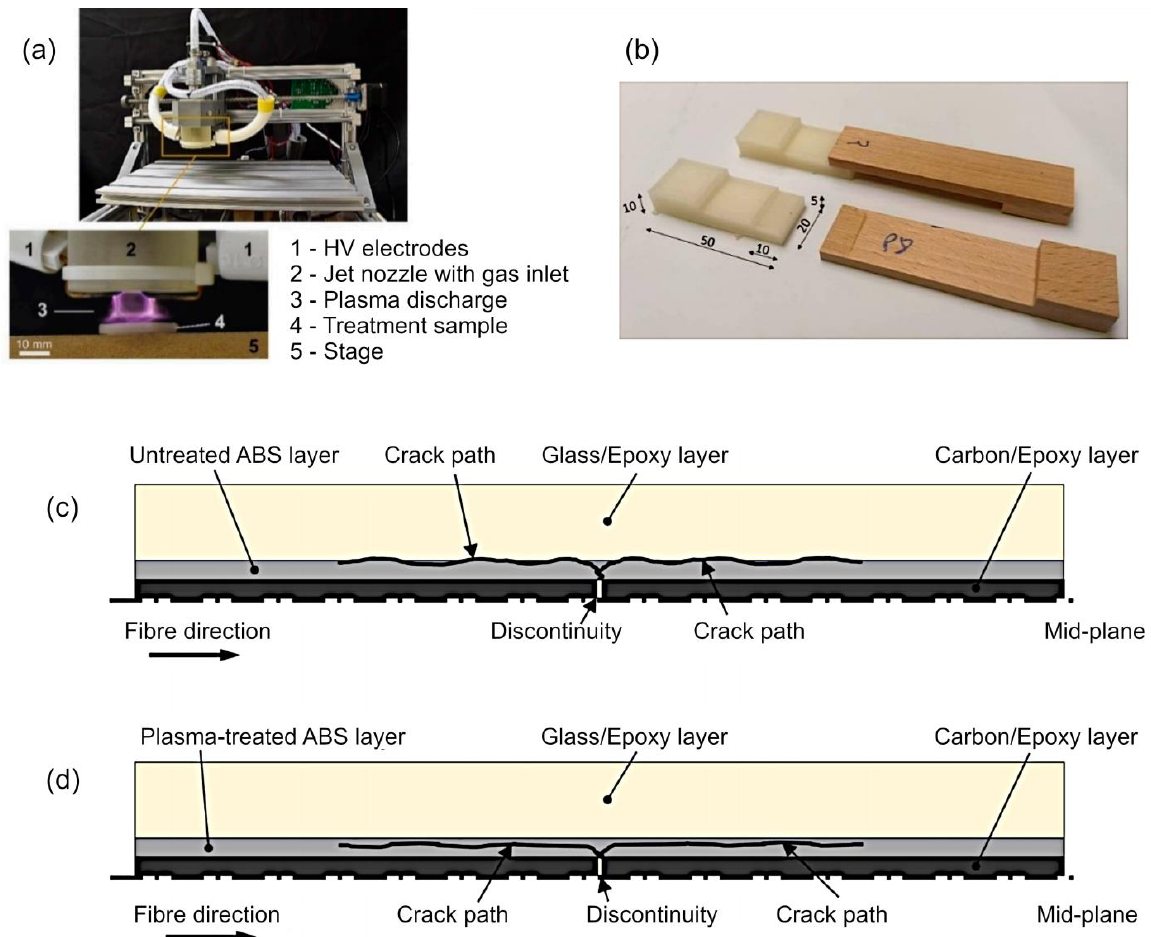
Figure 10. ( a , b ) Plasma device used for the surface treatment of 3D-printed samples on a CNC positioning system (top left image) with a gliding arc plasma jet ( a ), and sample for testing the bond shear strength ( b ). Reproduced from Kariž et al. (2018) [91] under conditions of the CC BY license. ( c , d ) Representation of the crack path in ABS-interleaved hybrid composites ( c ) with untreated ABS ( d ) with plasma-treated ABS. Reproduced from Marino et al. (2020) [92] under conditions of the CC BY license.